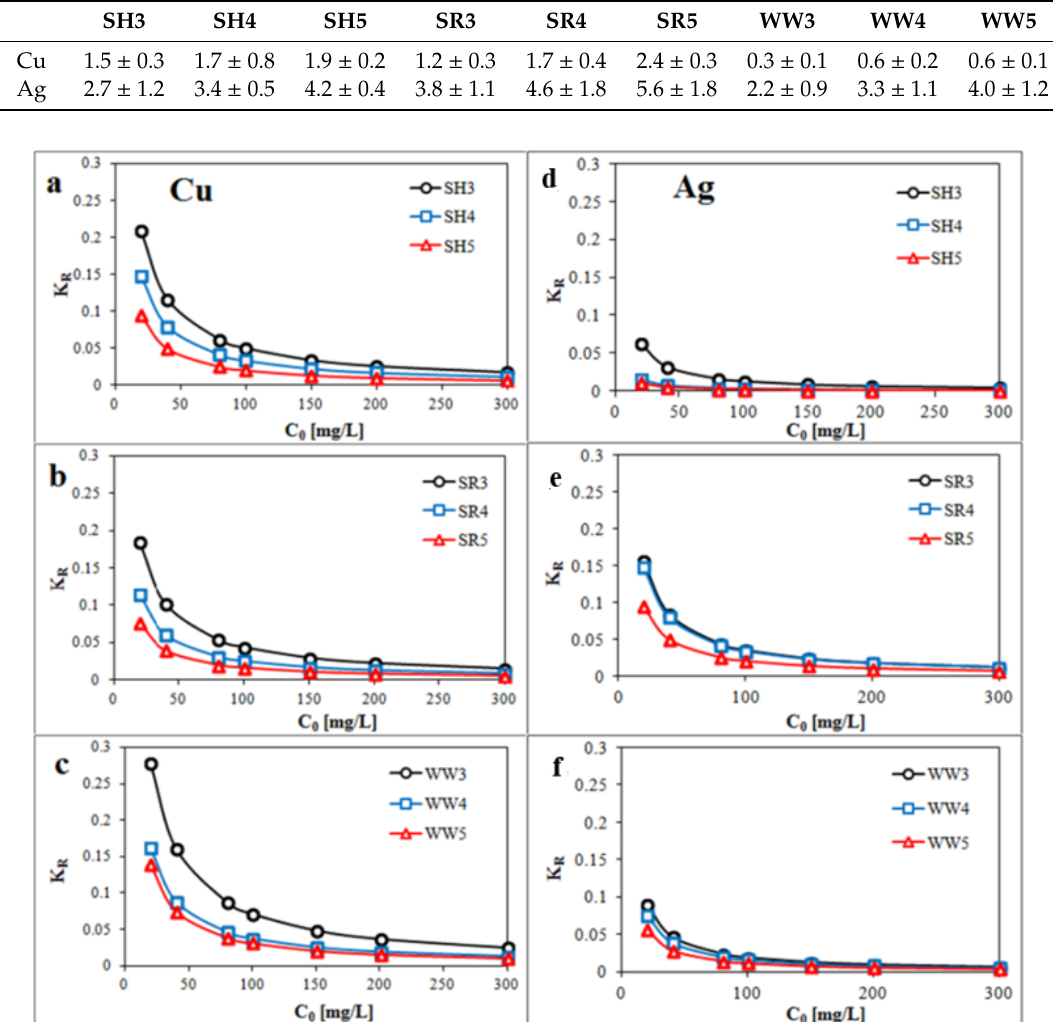
Table 6. Specific surface areas occupied by the metal ions (m 2 / g) with standard deviations ( n = 3):